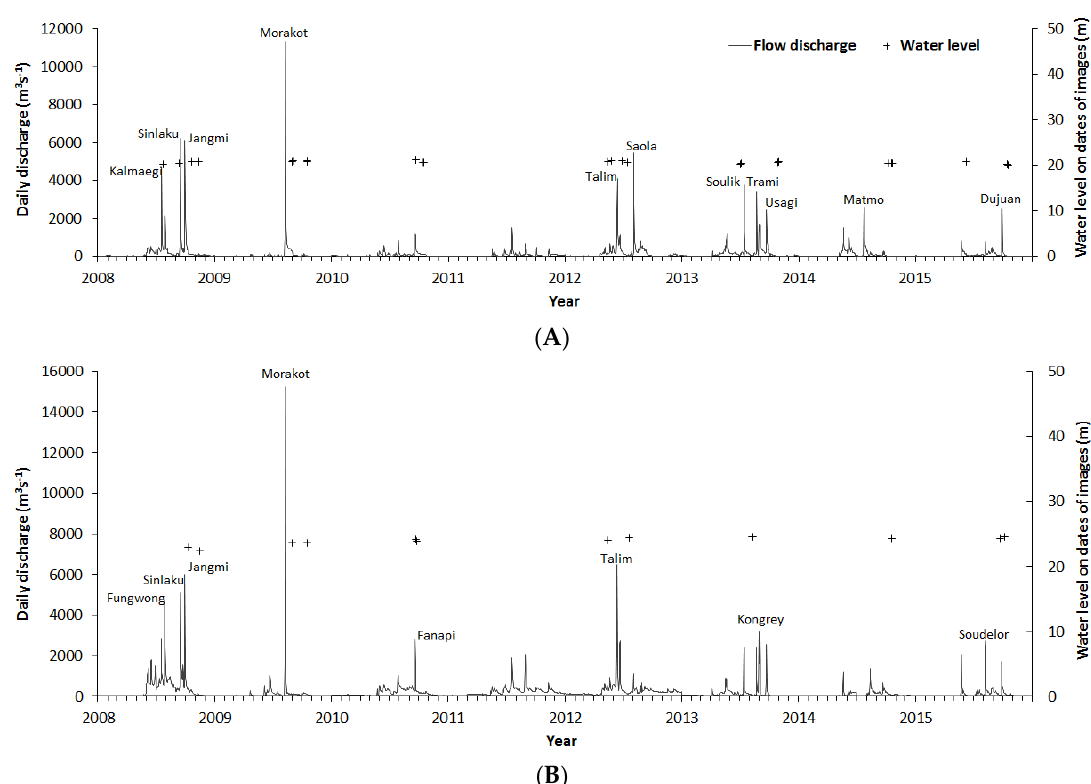
Figure 2. The hydrographs of daily discharge at flow gauge station Xizhou Bridge on the Zhuoshui River ( A ); and Liling Bridge on the Gaoping River ( B ). The locations of stations are marked on Figure 1. The names of typhoons are tagged on flow peaks. Crosses indicate water levels on dates of satellite images. The exact dates in 2011 are missing.